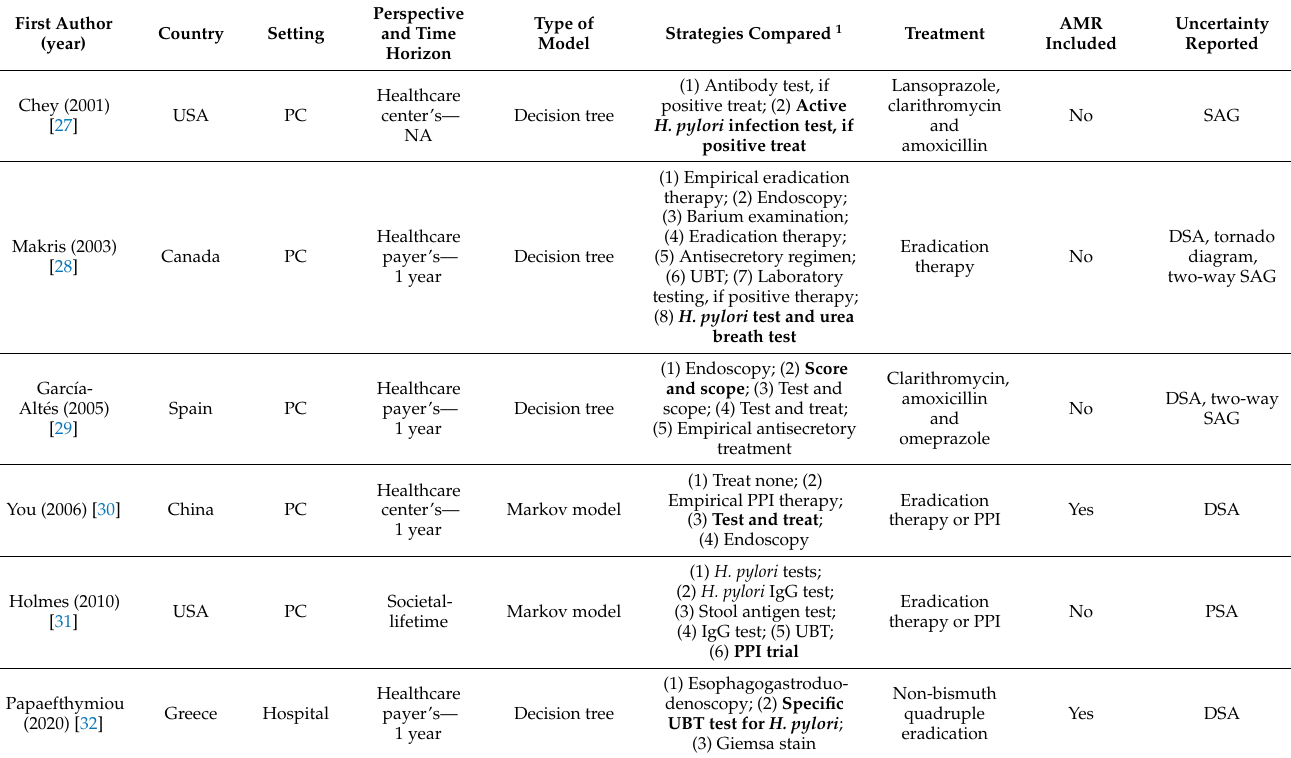
Table 2. Articles related to diagnosing H. pylori infection associated with